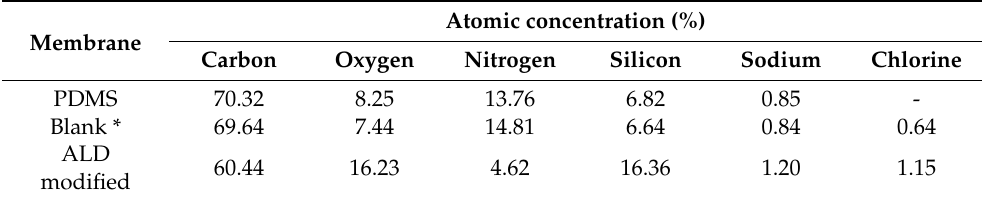
Table 4. Atomic concentrations in PDMS and ALD-modified membranes by XPS.